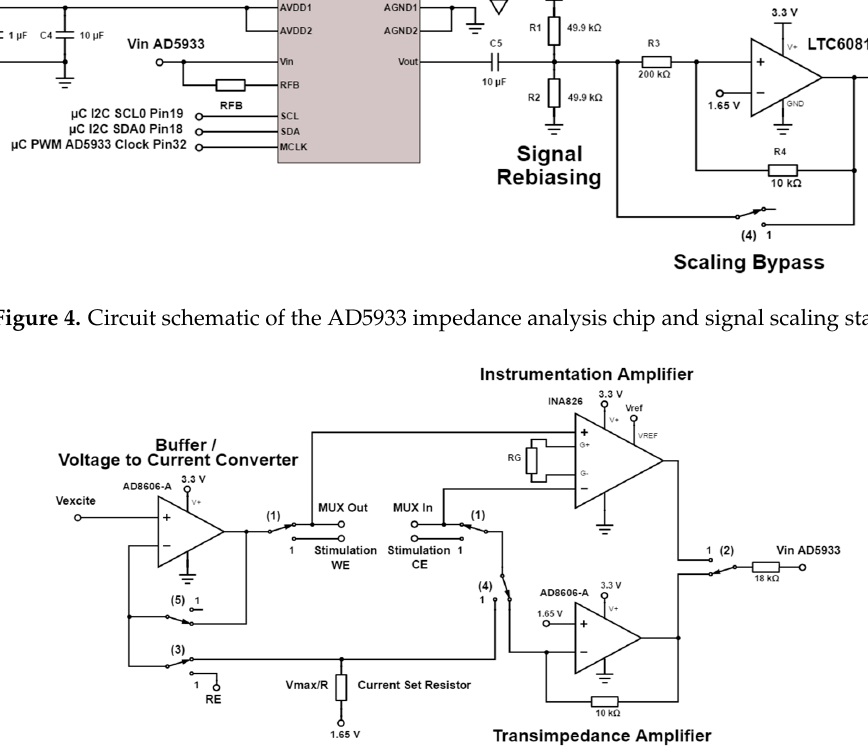
Sensors 2017 , 17 , 59